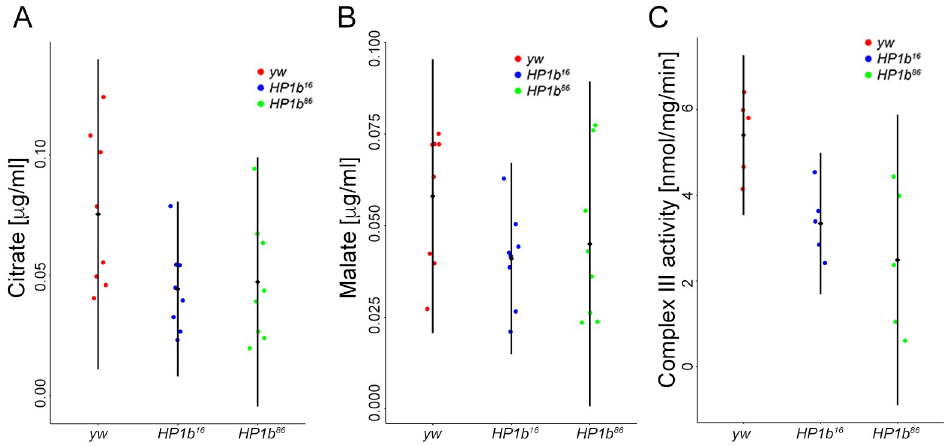
mutants. X-axis: Genotypes. Y-axis: Metabolite levels in μ g/ml. n = 4 per sex and genotype. C . Mitochondrial function assays indicate that Complex III activity is reduced in HP1b mutant animals (males). X-axis: Genotypes. Y-axis: enzyme activity in mmol/mg/min. n = 5 per